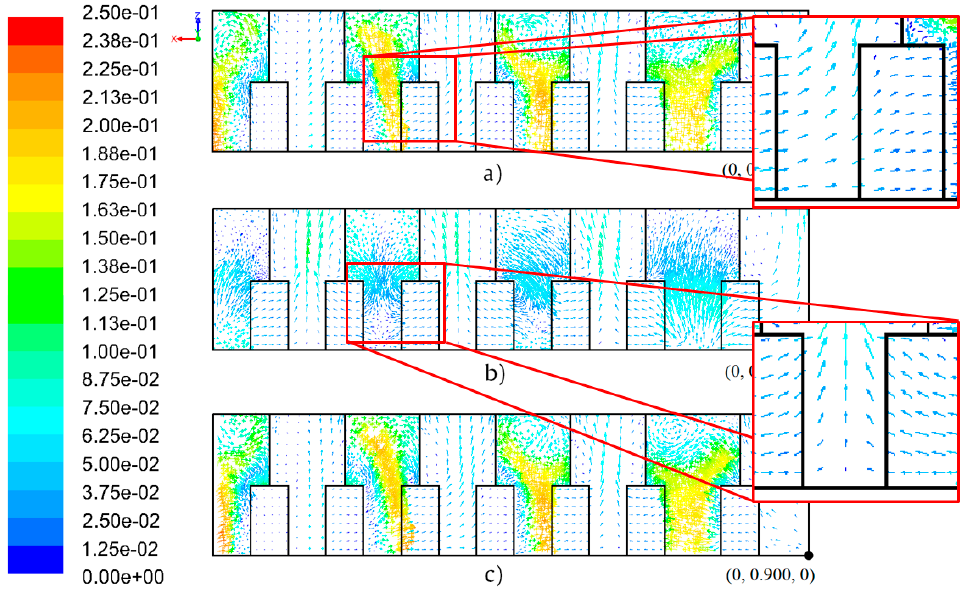
Figure 23. The results of the dimensionless velocity vectors for the minimum air flow velocity in the x–z plane represented through the planes: ( a ) y adm = 0.100; ( b ) y adm = 0.485; and ( c ) y adm = 0.900.